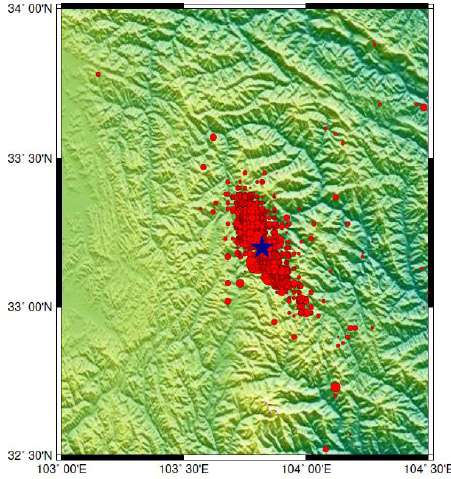
Figure 1. Map of the location of Jiuzhaigou M7.0 earthquake and its aftershocks distribution from the mainshock to October 22, 2017 for M L ≥1.0. Blue star indicated epicenter location of the mainshock, and red dots indicated aftershock